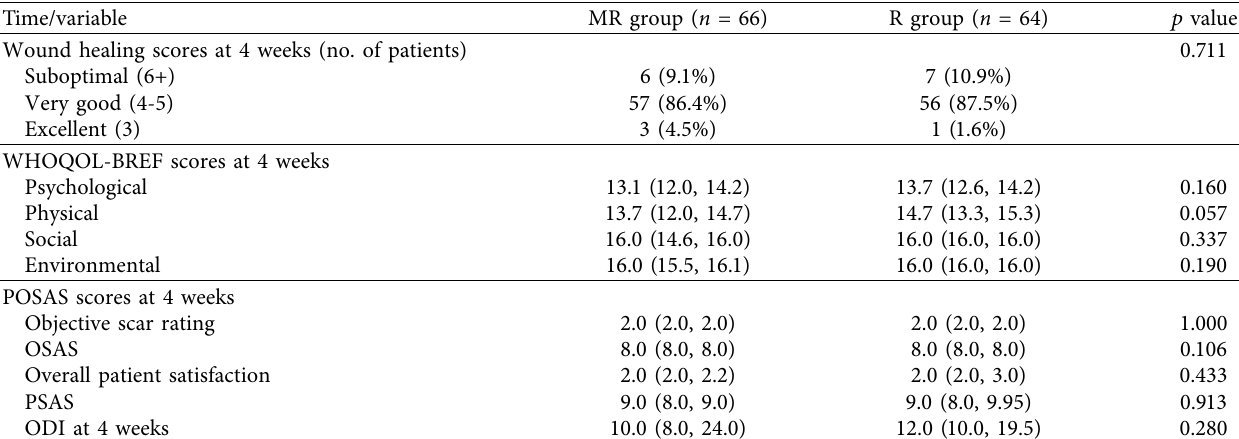
Table 4: Comparison of wound healing scores, WHOQOL-BREF scores, POSAS scores, and ODI between the MR (methylprednisolone plus ropivacaine) group and the R (ropivacaine) group at 4